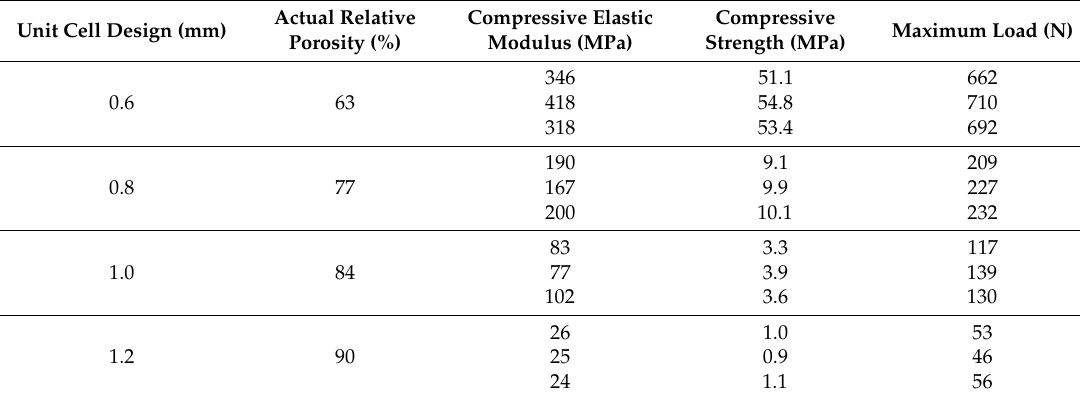
Table 1. Experimental